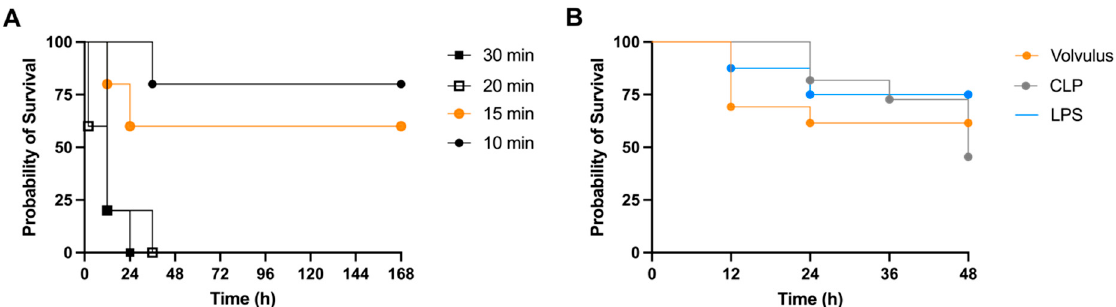
Figure 1. Survival rate in midgut volvulus, cecal ligation and puncture (CLP), and i.p. LPS model. ( A ) Initially, midgut volvulus was performed in a total of 20 mice and left in this position for 10, 15, 20 or 30 minutes before it was relaxed (n = 5 per group). Note, the 48h mortality was 20%, 40%, 100%, and 100%, respectively. ( B ) Survival rate of the CLP (n = 11), and the LPS (n = 8) sepsis model as compared to midgut volvulus performed for 15 min (n = 13) (48h mortality 38 %). CLP model: the midportion of the cecum was alloyed and the distal portion of the cecum was punctured using a 19 G canula (48 h mortality 55 %). LPS model: i.p. injection of 10 mg/kg LPS-EB ultrapure (48h mortality 25 %).